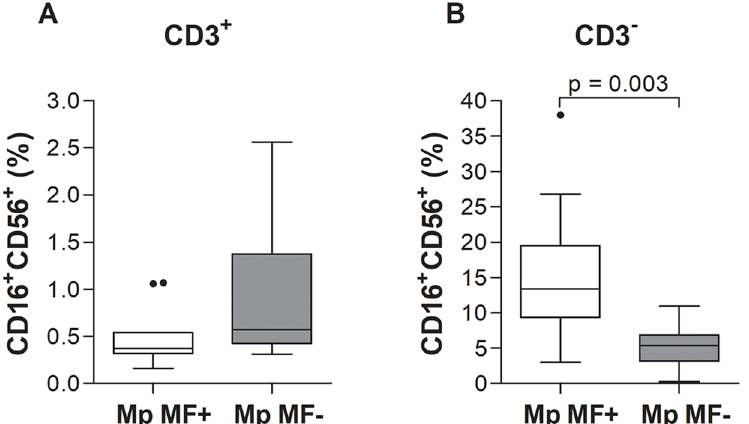
Fig 6. Elevated frequencies of CD3 - CD16 + CD56 + natural killer cells in peripheral blood of M . perstans - microfilaremic individuals. Using flow cytometry, peripheral whole blood cells from M . perstans microfilaremic (Mp MF+; n = 11) and amicrofilaremic (Mp MF-; n = 10) individuals were analyzed for frequencies (%) of ( A ) CD3 + T cells co-expressing CD16 and CD56 for NKT cells and ( B ) CD3 - cells co-expressing CD16 and CD56 to determine NK populations. Graphs show box whiskers with median, interquartile ranges and outliers. Statistical significances between the indicated groups were obtained using the Mann-Whitney-U-test.